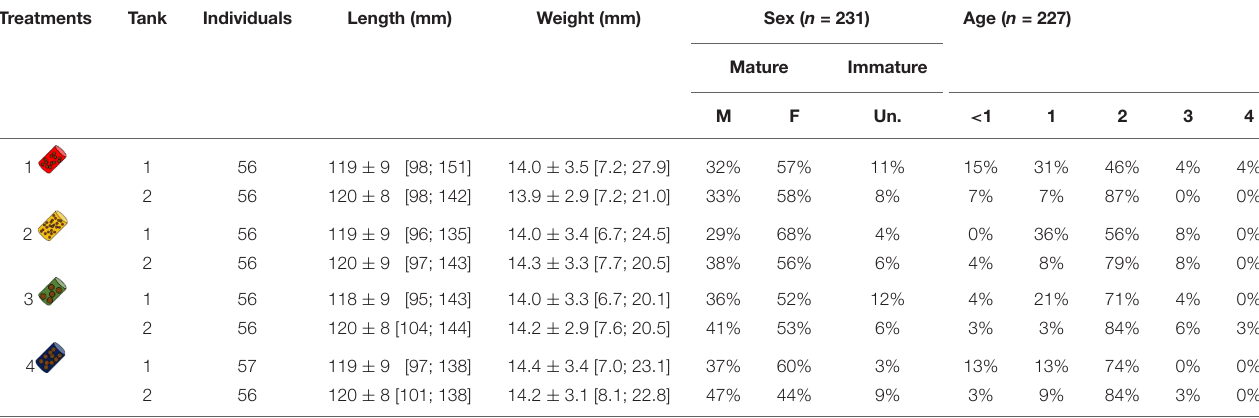
TABLE 1 | Number of individuals, mean length ( ± SD) and length range (95% CI), mean weight ( ± SD) and weight range (95% CI), sex ratio (in %) of males (M), females (F) or unidentified (Un.), age class ratio (in %) for each tank and each treatment. Sex ratios and age class ratios are based on samples of March and June (sample size is given by n ).